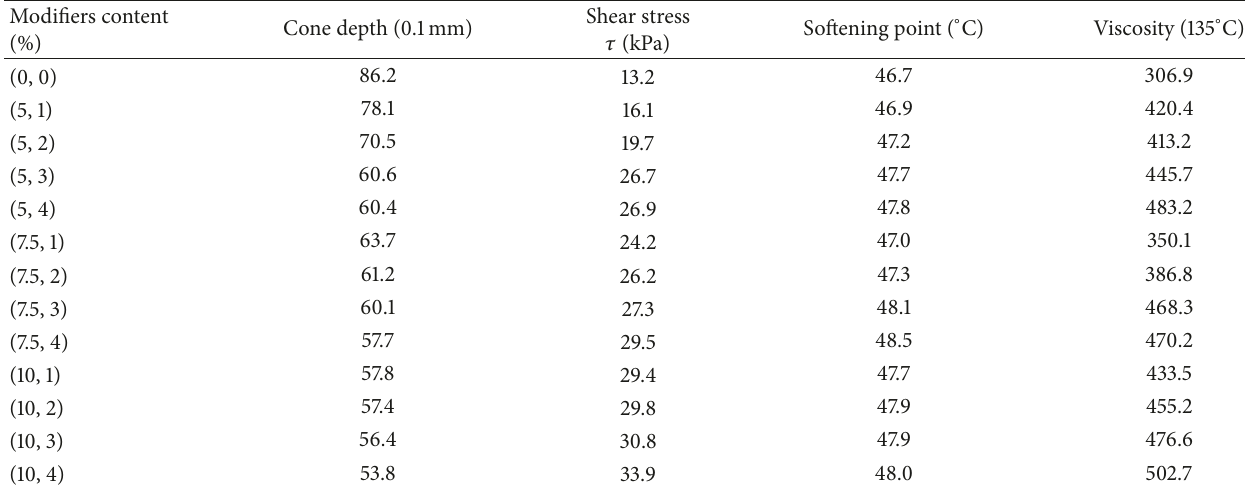
Table 5: Conventional test results of modified asphalt.